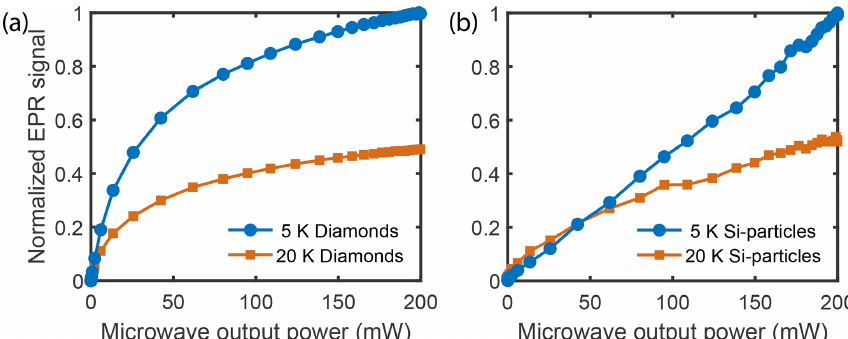
Figure 7. Power-dependent LOD-EPR signal at 5 and 20K using the plated waveguide. (a) Diamond particles. (b) Silicon